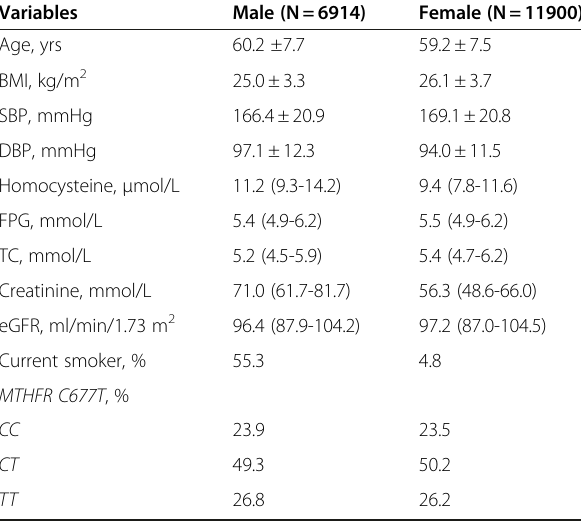
Table 1 Phenotypic characteristics of study participants Variables